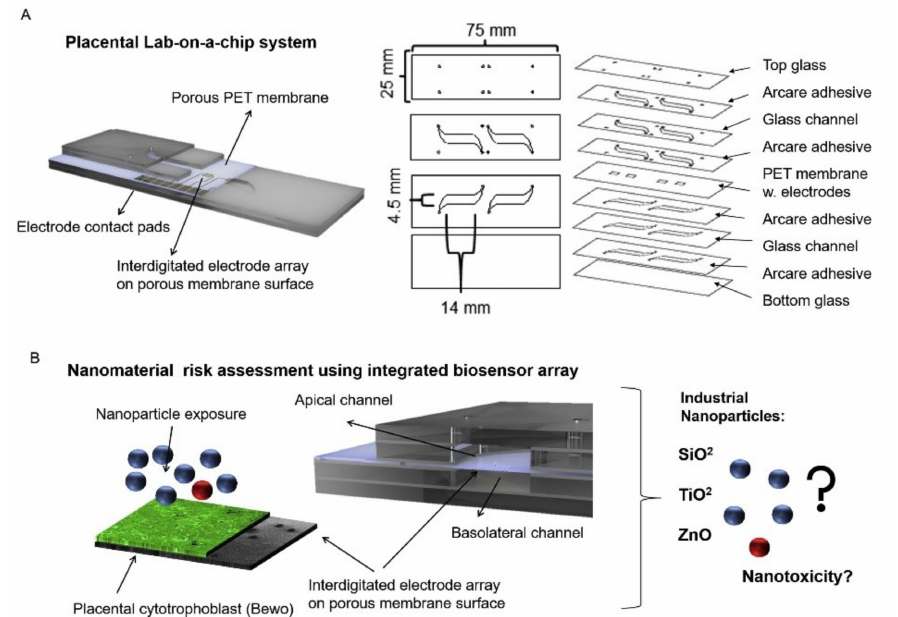
Figure 2. A lab-on-a-chip experiment investigating how nanomaterial can negatively impact a placenta, reproduced with permission from Ref. [94]. ( A ) Fabricated porous PET membranes are located under an impedance biosensor array. ( B ) To test the lab-on-a-chip, a nanomaterial risk assessment at the placental barrier is